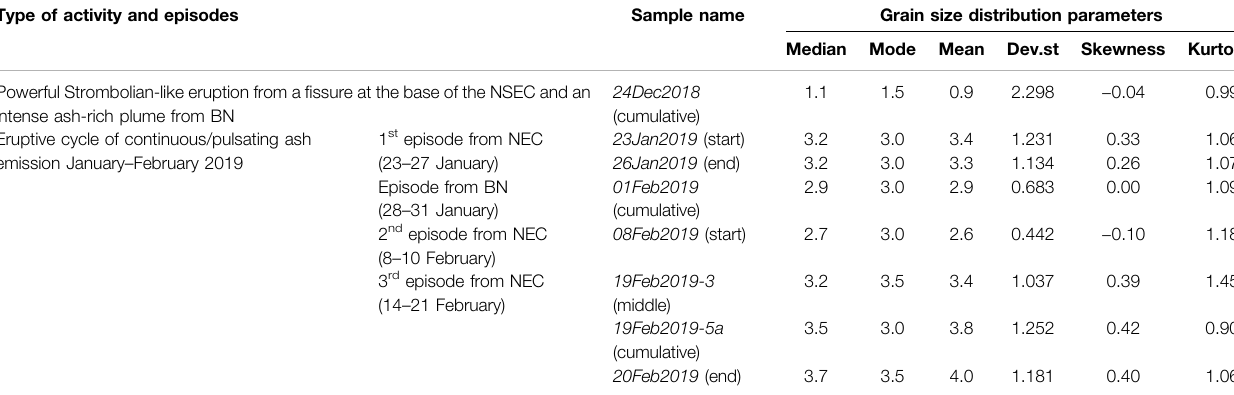
TABLE1| Overviewofthestudiedsamplesinthecontextoftypeofactivity,relatedepisodewithinthecycleofashemission,indicationofthephase(inbrackets)towhichthe samples correspond, and grain size parameters (Inman, 1952). Type of activity and